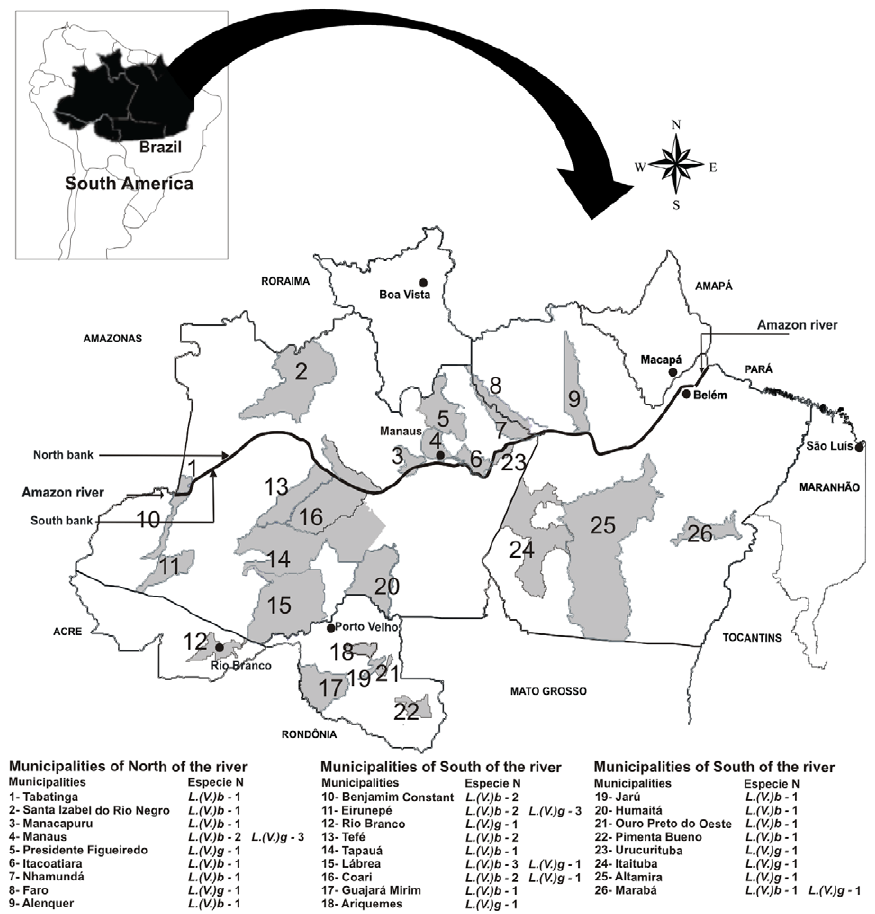
Figure 1. Spatial distribution of ML cases by species according to the municipality of origin.